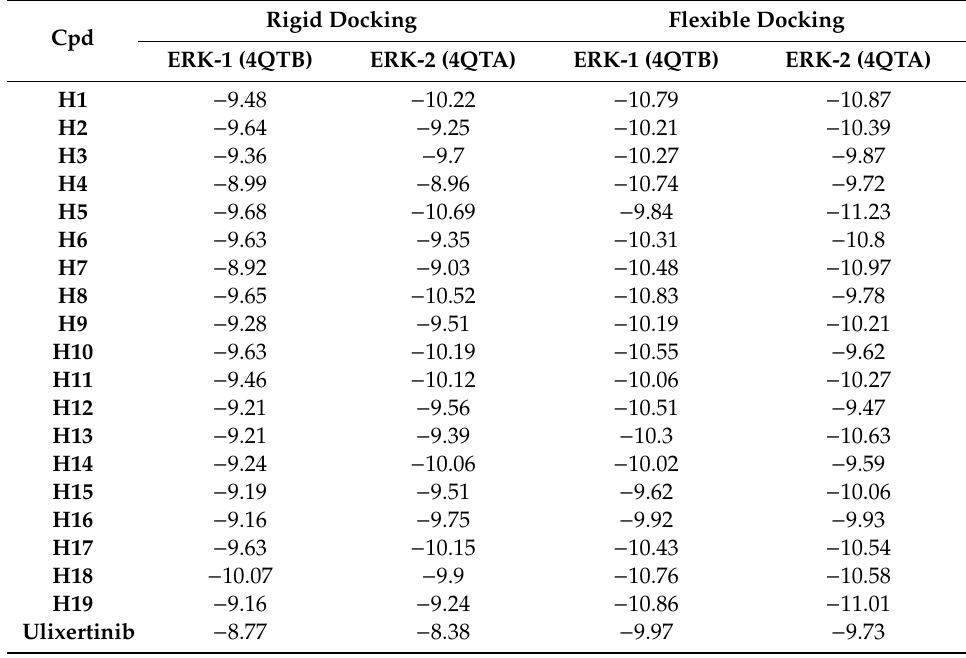
Rigid Docking Flexible Docking Cpd Rigid Docking Cpd